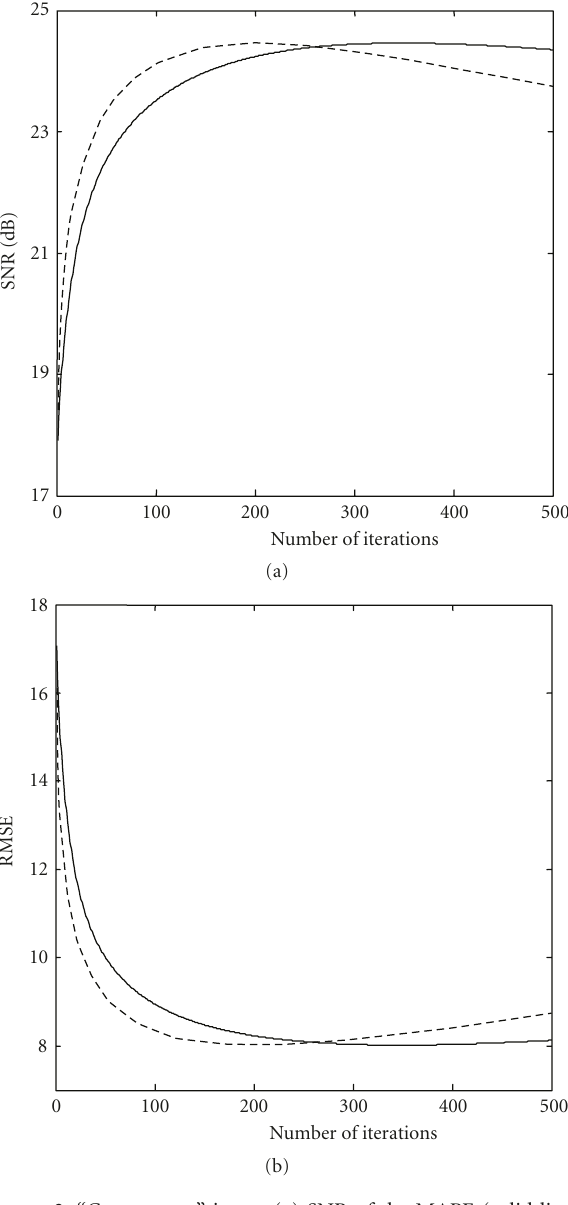
Figure 2: “Cameraman” image (a) SNR of the MAPE (solid line) and AAMAPE (dotted line). (b) RMSE of the MAPE (solid line) and AAMAPE (dotted line).